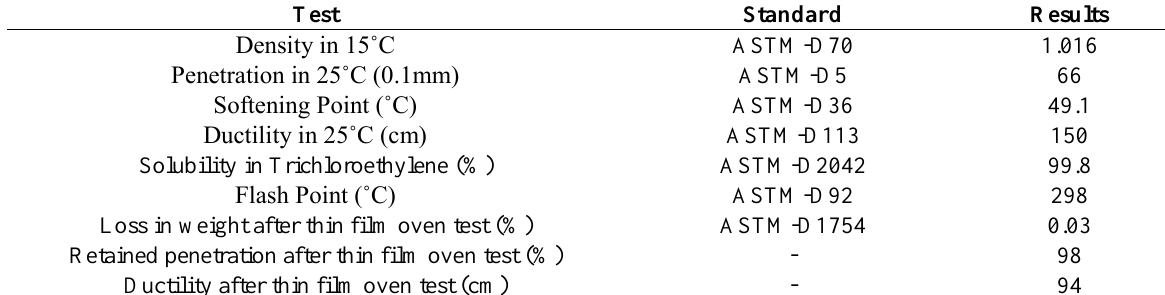
Fig. 1. Gradation of the mixture aggregates Table 2. Properties of the bitumen used in this research